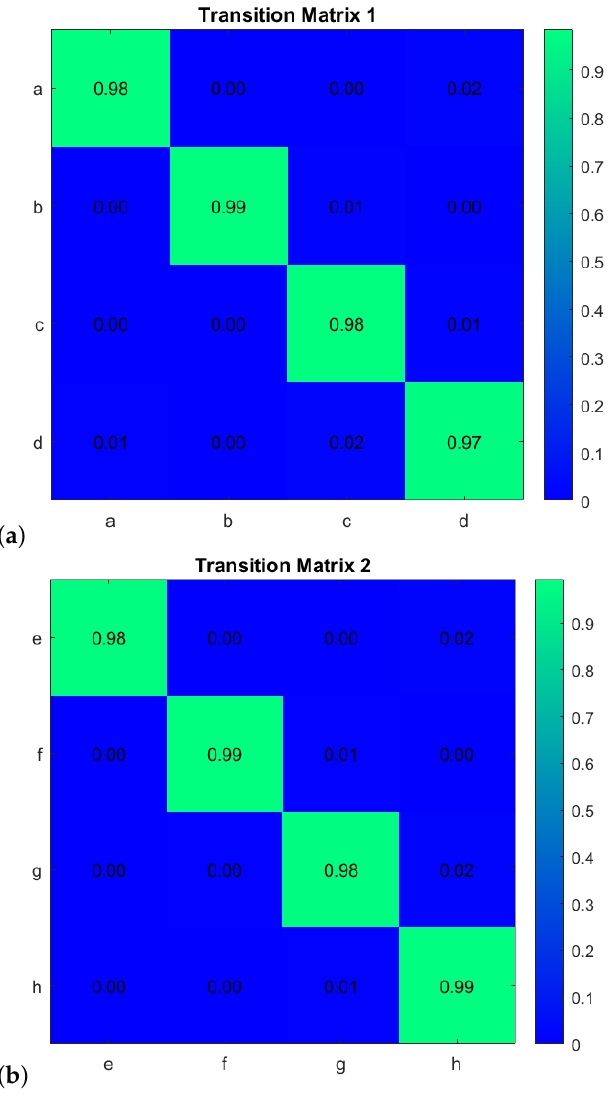
Figure 22. Transition probability matrices obtained from the model M 2 for ( a ) agent 1 and ( b ) agent 2 .